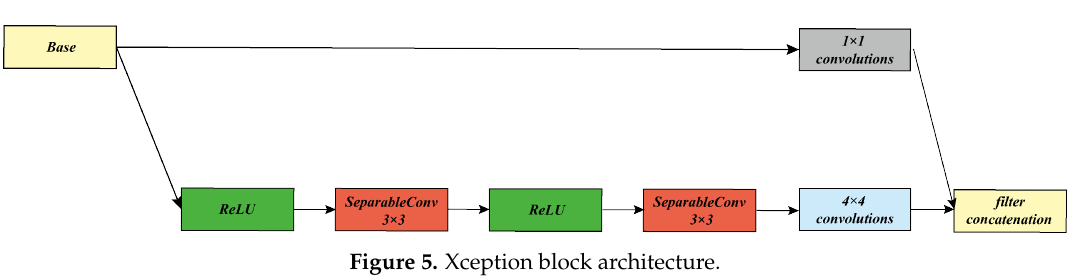
Figure 5. Xception block architecture.